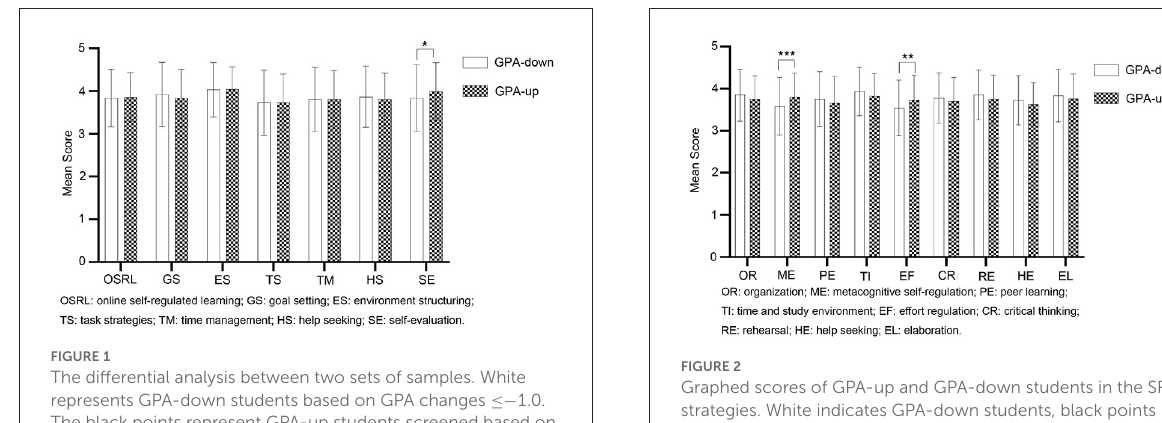
FIGURE1 The differential analysis between two sets of samples. White represents GPA-down students based on GPA changes ≤− 1.0. The black points represent GPA-up students screened based on GPA changes ≥ 1.0. Stars represent significant differences between the two groups.